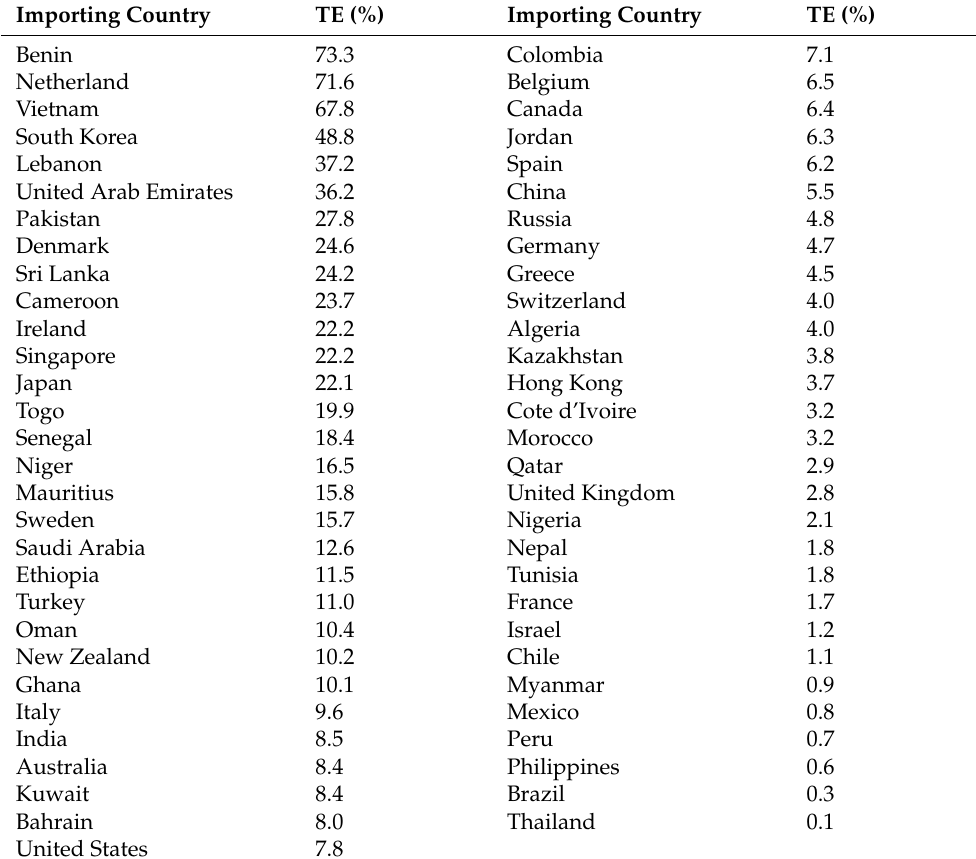
Table 4. Malaysia Palm Oil Export Technical Efficiency